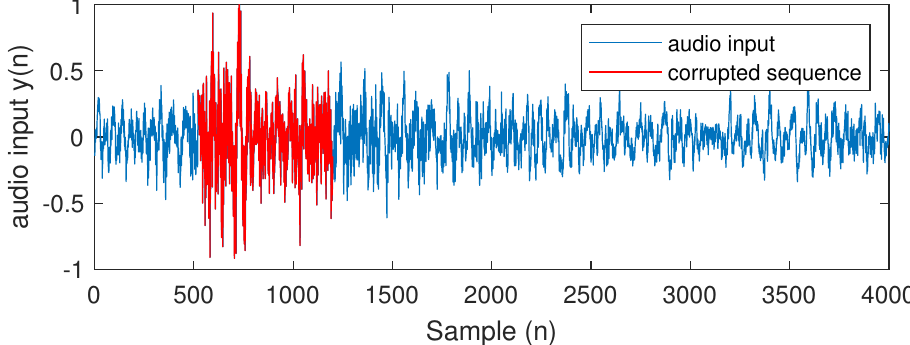
Figure 7. An example of an audio recording corrupted with impulse noise ( red